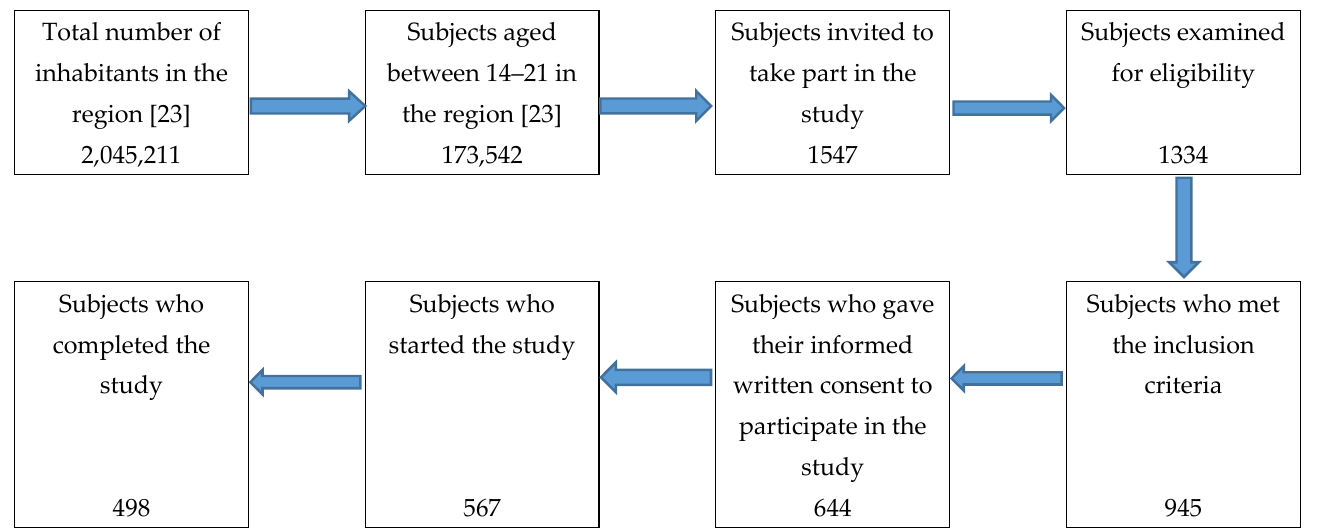
Figure 1. Flow Chart for selection of study participants.